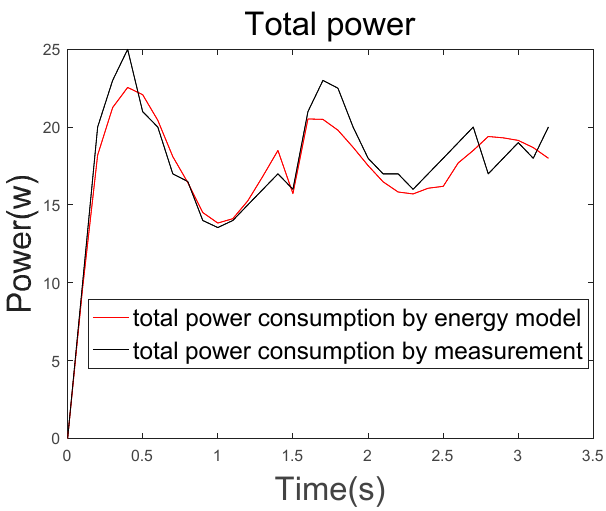
Figure 13. Comparison between energy model and measurement.